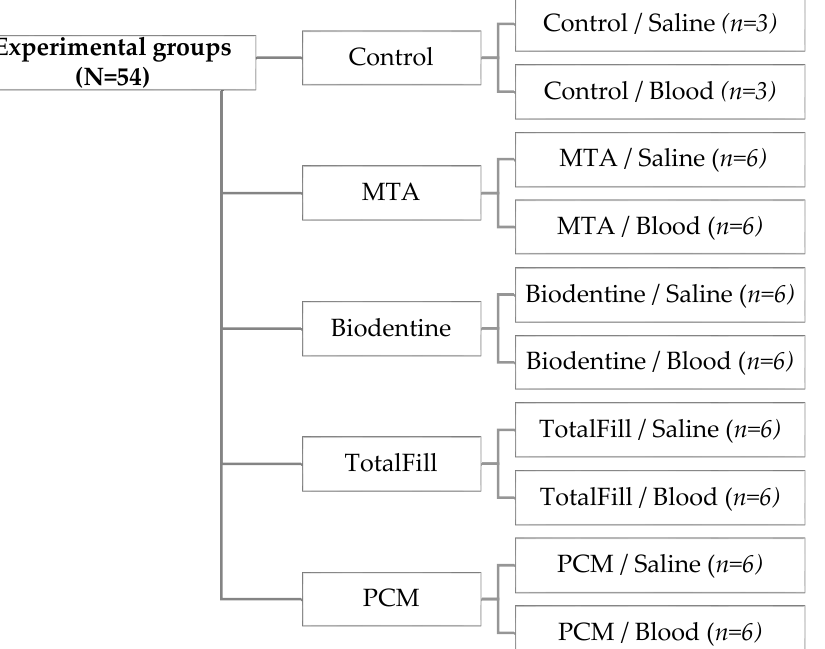
Figure 1. Experimental groups description (Saline: saline solution; MTA: ProRoot MTA; TotalFill: TotalFill BC Putty; PCM: experimental pulp capping